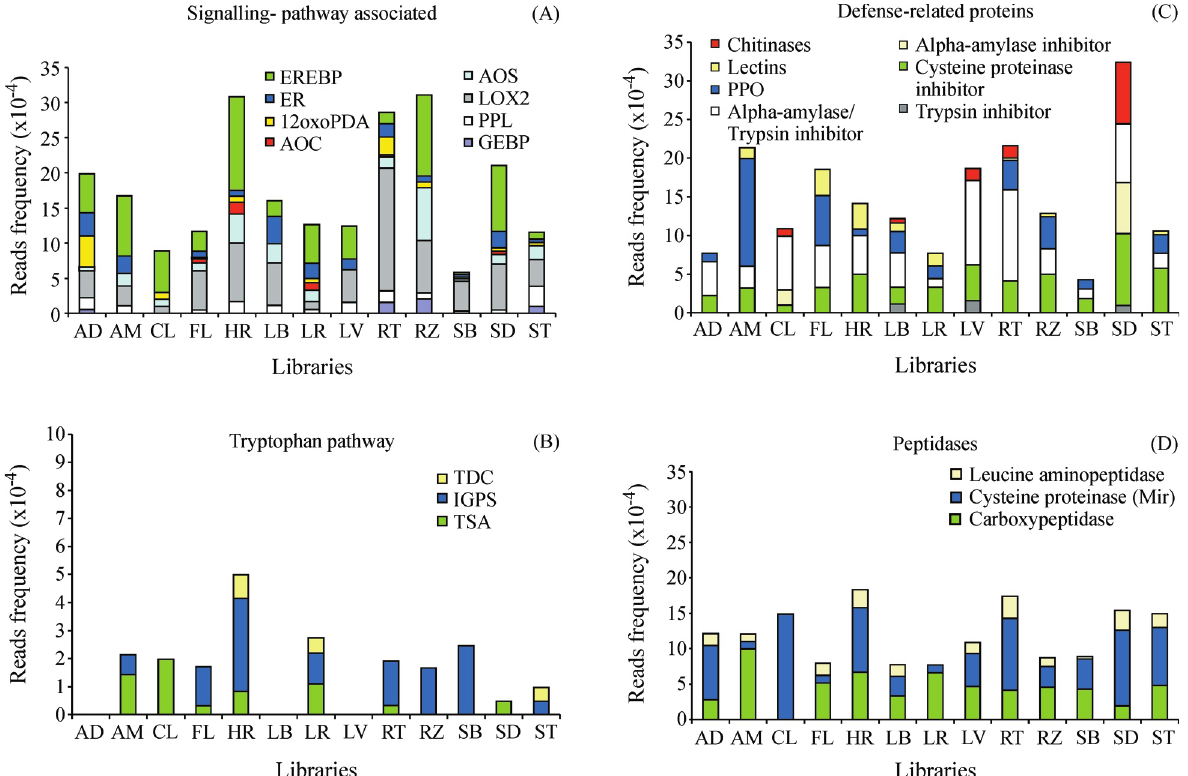
Figure 2 - In silico expression analysis of defense-related proteins against insects using sugarcane cDNA libraries from different tissues. Abbreviations are given in the legend to Figure 1 except when shown. 2A. Signaling-associated pathway (PPL = phospholipase); 2B. Tryptophan pathway; 2C. De- fense-related proteins; 2D. Putative peptidases. Abbreviations used in the libraries: SD , seeds; FL , flowers; LR , leaf roll; LV , etiolated leaves; AM , api- calmeristem; LB ,lateralbud; SB ,stembark; ST ,stem; RZ ,leaf-roottransitionzone; RT ,root; AD ,plantletswithoutdevelopedleavesandrootsinfected with Acetobacter diazotroficans growing in vitro; HR , plantlets without developed leafs and roots infected with Herbaspirillum rubrisubalbicans grow- ing in vitro ; CL , calli submited to light/dark and temperature (4 °C and 37 °C)